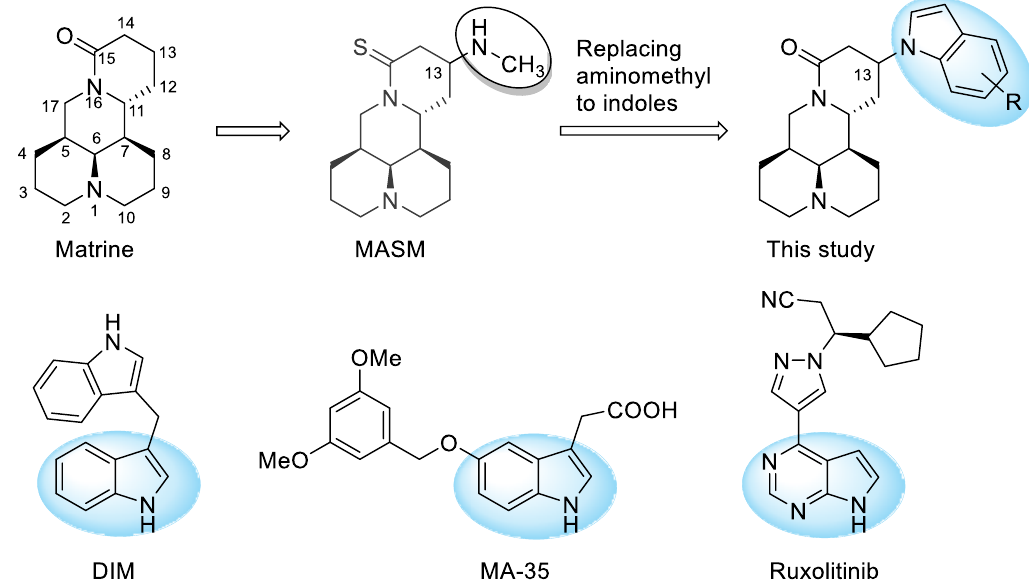
Figure 1. Chemical structures of matrine, lead compound MASM, indole-containing anti-fibrotic drug or candidates, and the structure modification or candidates, and the structure modification strategy.